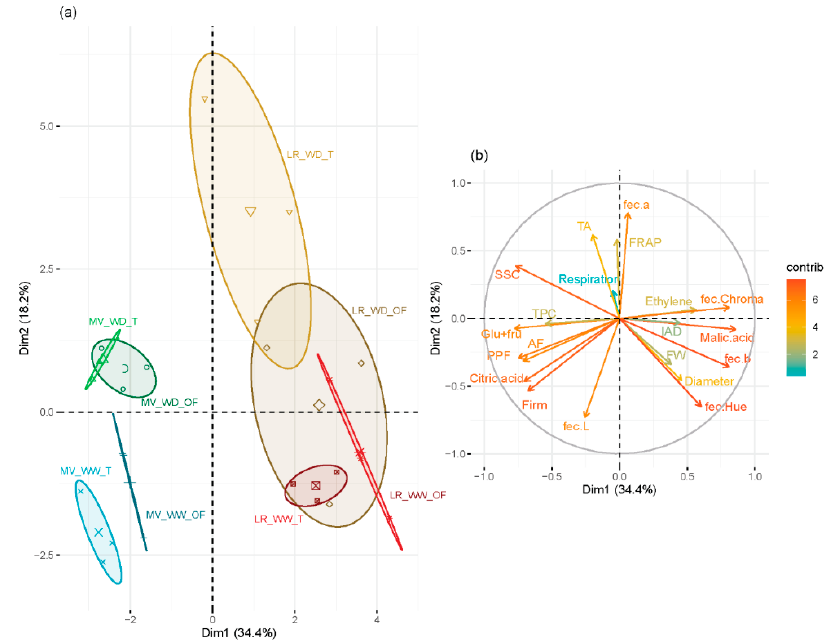
Figure 1. Dissimilarities based on fruit’s physical and chemical traits recorded at harvest showing the effects of water regime (water deficit, WD; well-watered, WW) and growing environment (open field, OF; tunnel, T) on two Penjar genotypes (landrace, LR; modern cultivar, MV). Scores are represented on the two first principal components (Dim1–Dim2), accounting for 52.8% of the total variation. ( a ) Phenotypic values grouped by treatment (the center of the ellipse is signaled); ( b ) correlation loadings of the variables with the principal components. Abbreviations: ( a ) the abbreviations indicate the genotype (MV/LR), the water regime (WD/WW), and the environment (OF/T); for instance, MV_WD_T indicates: modern variety, water deficit, tunnel; ( b ) FW, fruit weight; AF, acoustic firmness; PPF, peak positive force; Firm, firmness; fec., fruit external color CIELAB coordinates (L, a, b, Chroma, Hue); FRAP, antioxidant capacity; TPC, total phenolic content; SSC, soluble solids content; TA, titratable acidity; IAD, Index of absorbance difference; Glu + fru, glucose + fructose content.